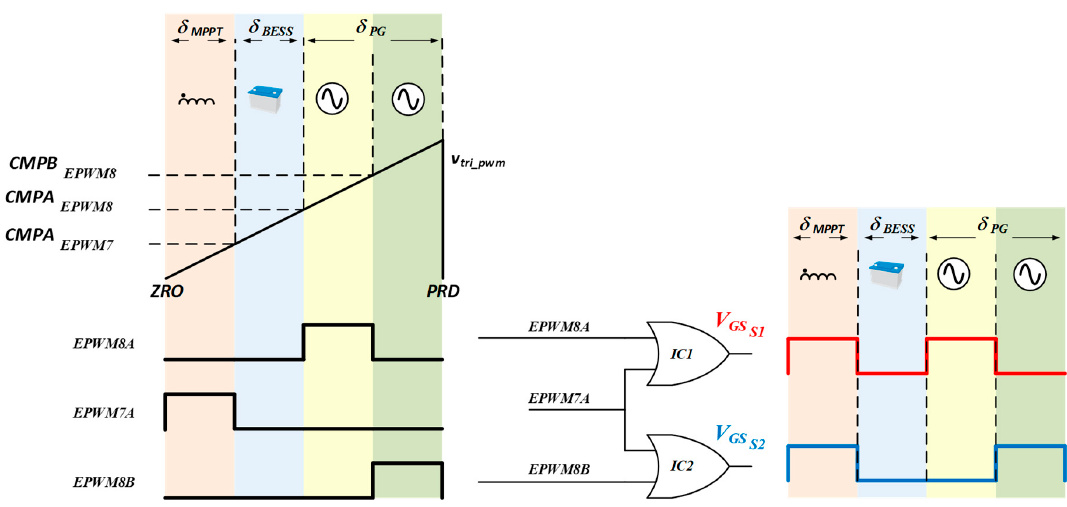
Figure 13. Circuit used to obtain the PWM signals for the semiconductors S 1 and S 2 .